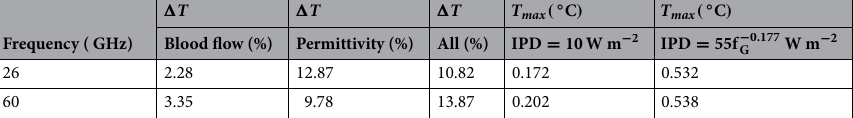
Table 3. Temperature rise variation with age (when considering the effect of blood flow, permittivity and all the contribution contextually) and maximal temperature rise (absolute value).